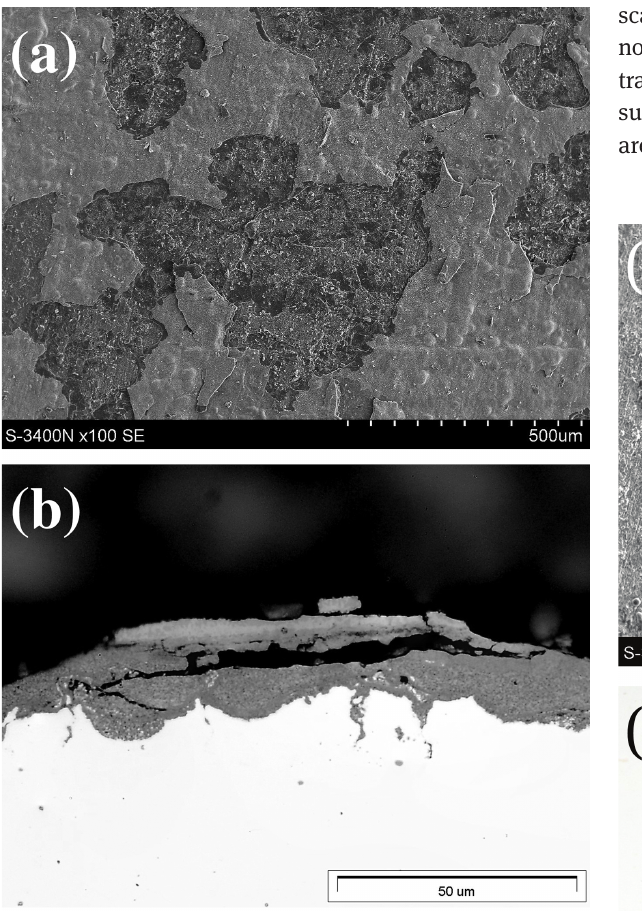
Figure 3: Morphology of the scale formed on the X2CrNiMo17-12-2 steel during oxidation under thermal shock conditions: (a) scale surface (b) cross-section of oxidized sample.